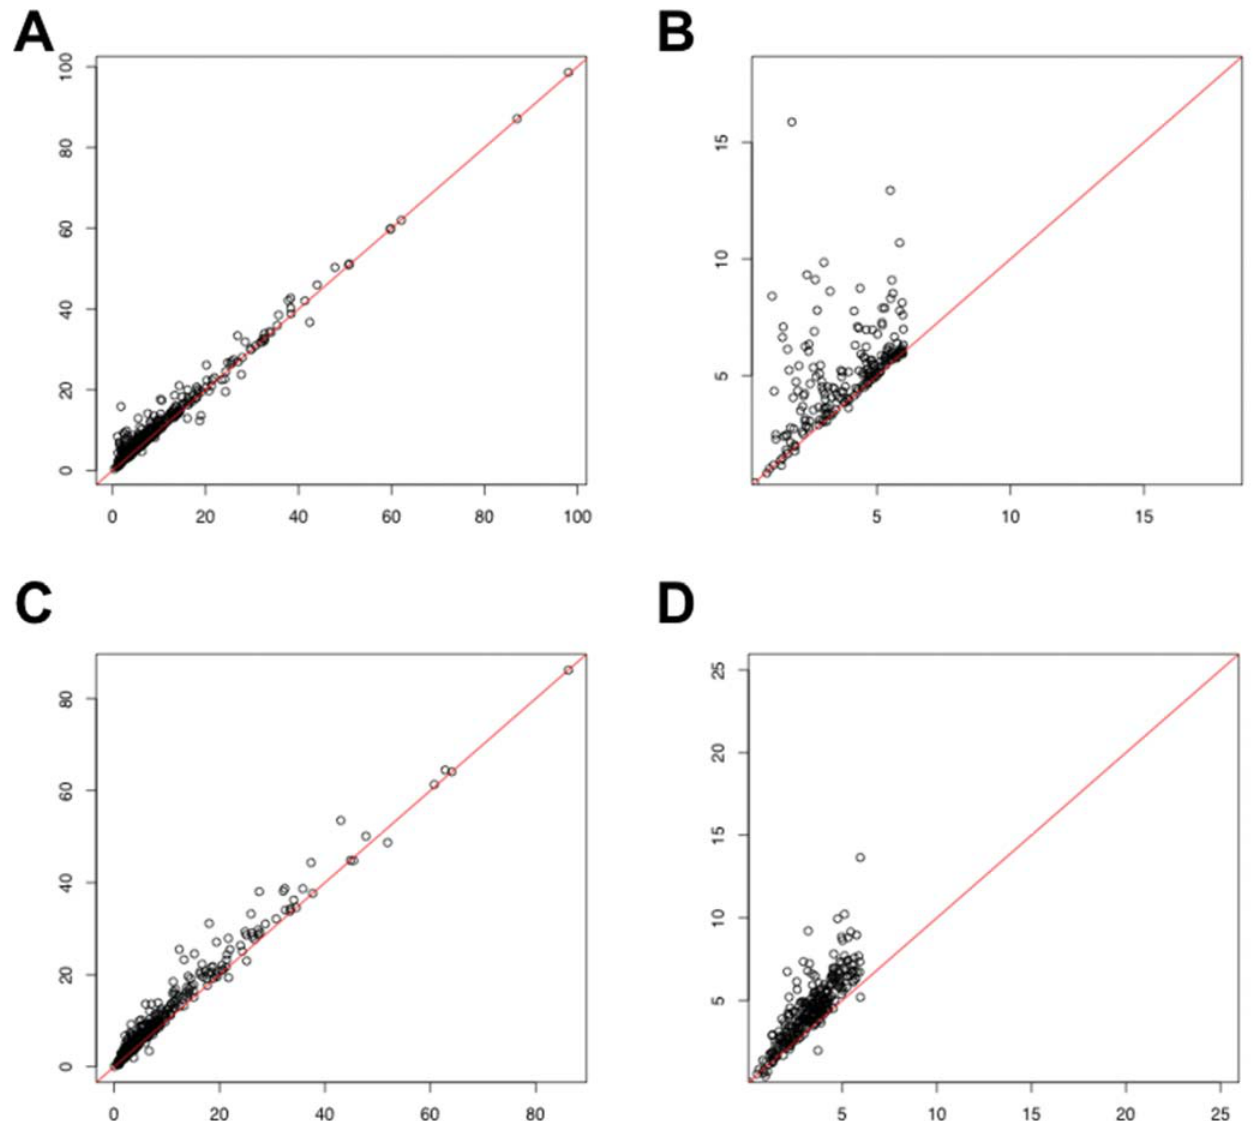
Figure 5. Effects of probe selection on genes differentially expressed between liver and muscle. ( A ) 438 transcript clusters were defined as overexpressed in liver relative to muscle, based on 3 9 expression array data (see Materials and Methods). Using gene expression indexes computed from all core probes or the selected core probes, we calculated the average gene expression fold change in three liver samples over three muscle samples. The X- axis shows the fold change using all core probes, and the Y-axis shows the fold change using selected core probes. The red line indicates the 45- degree line (Y=X). ( B ) A magnification of (A) when the fold change computed from all core probes was less than 6. ( C ) 500 transcript clusters were defined as overexpressed in muscle relative to liver, based on 3 9 expression array data (see Materials and Methods). Using gene expression indexes computed from all core probes or the selected core probes, we calculated the average gene expression fold change in three muscle samples over three liver samples. The X-axis shows the fold change using all core probes, and the Y-axis shows the fold change using selected core probes. The red line indicates the 45-degree line (Y=X). ( D ) A magnification of (C) when the fold change computed from all core probes was less than 6.